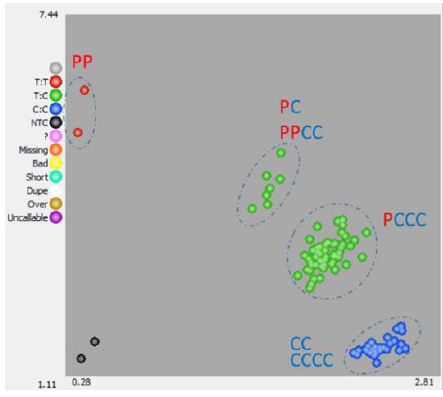
Figure 2. Example of allelic doses estimated with KASPar marker (P3_5432785) on the Volkamer lemon x Citrumelo population. P: Poncirus allele; C: Citrus